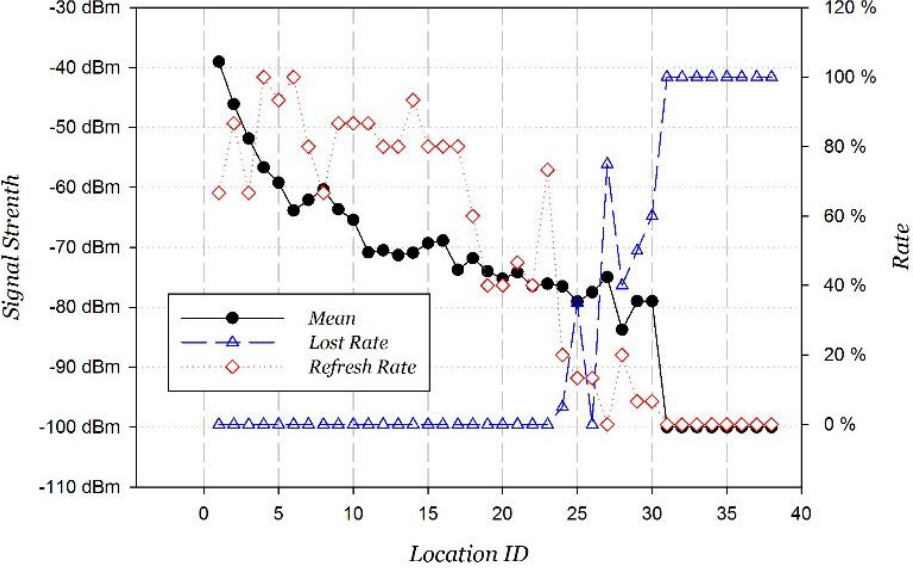
Figure 2. Wi-Fi variation on the move.